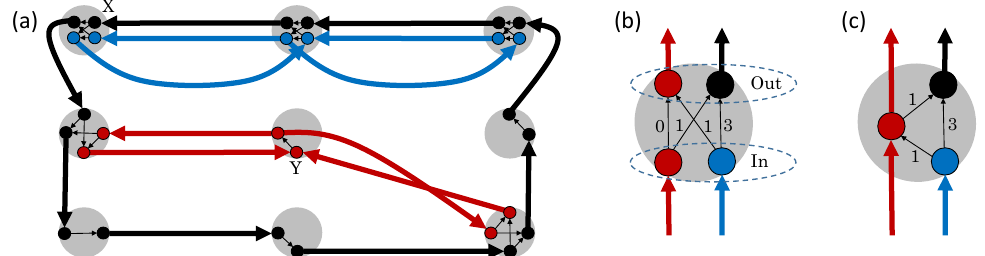
Figure 3. ( a ) The graph G (cid:48) = ( V (cid:48) , E (cid:48) ) formed from Figure 2 using the Kirby–Potts expansion method; ( b ) an example cluster of dummy vertices produced using the Kirby–Potts method; and ( c ) the corresponding cluster using the (problematic) restricted expansion